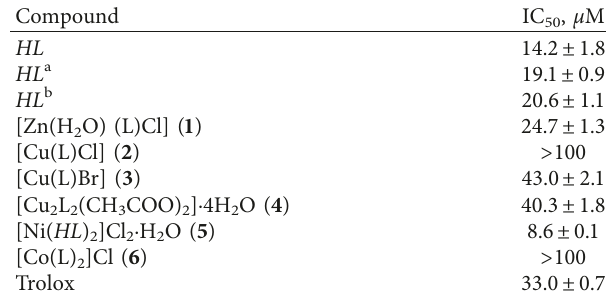
Table 7: IC 50 values of the synthesized substances toward ABTS radical